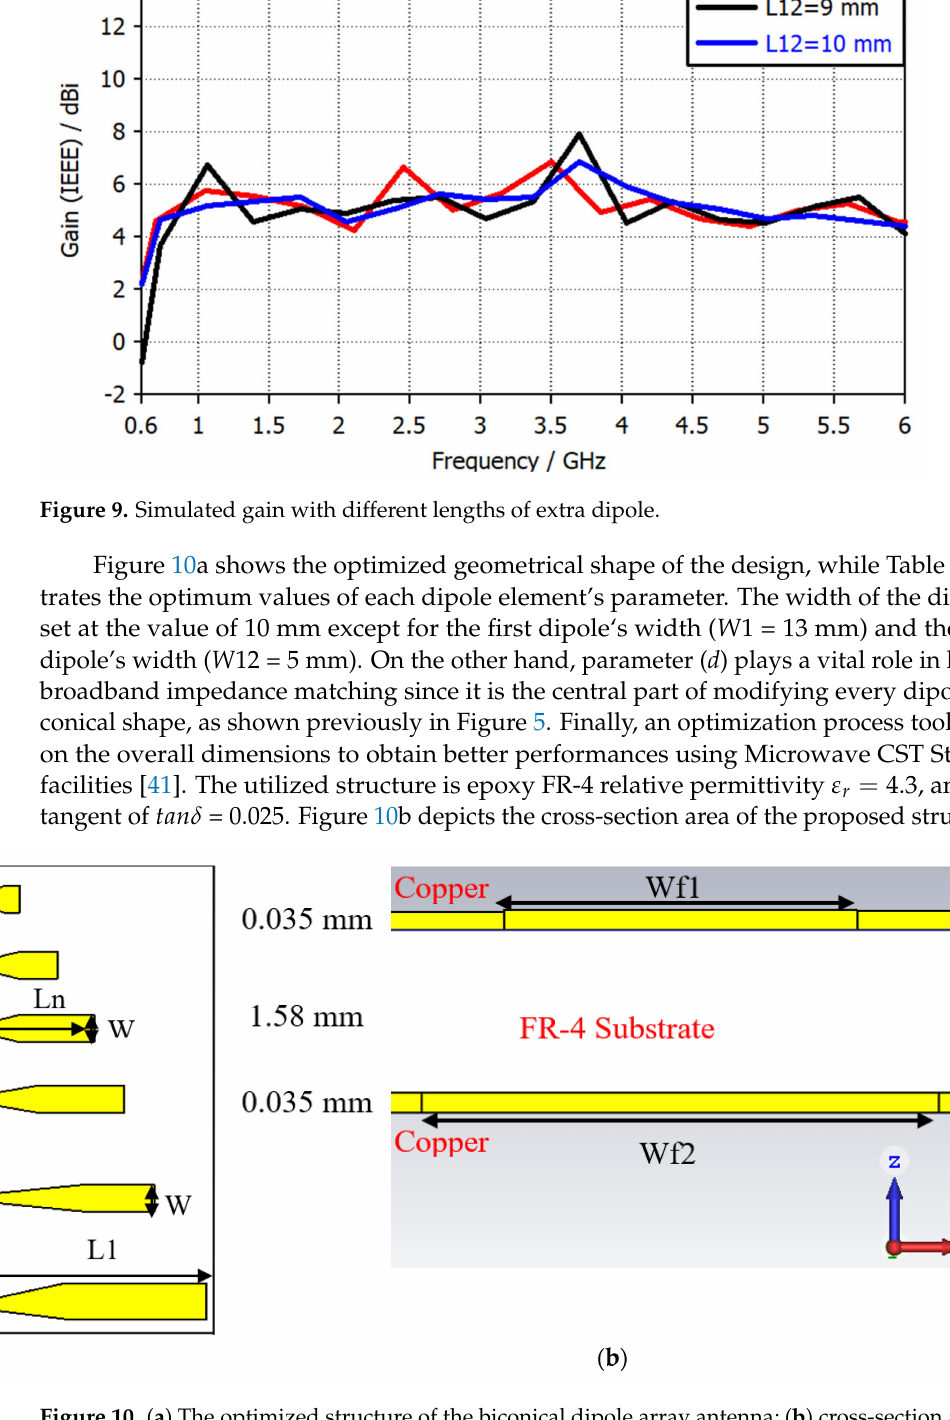
Figure 10. ( a ) The optimized structure of the biconical dipole array antenna; ( b ) cross-section area for the biconical dipole array